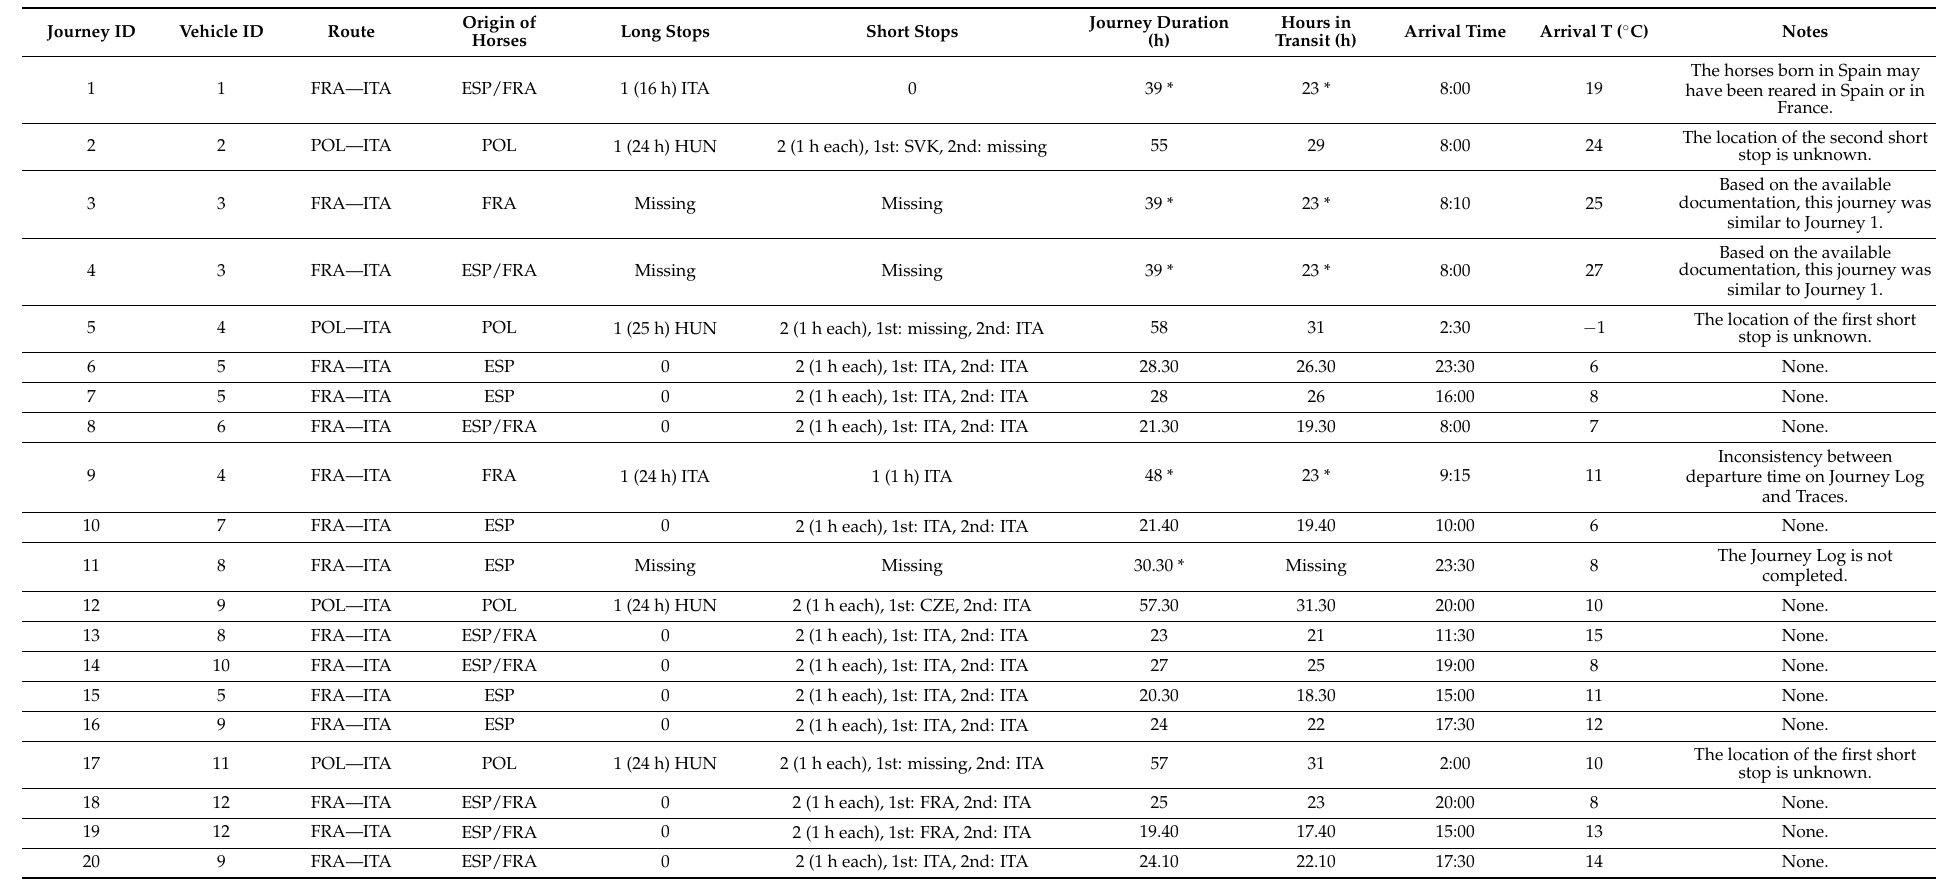
Table 6. Description of each journey, reporting the departure and arrival country, the country of birth of the horses, and the information about the journey (number and duration of stops; duration of the journey). * = Travel hours assumed from other documentation, not from Journey